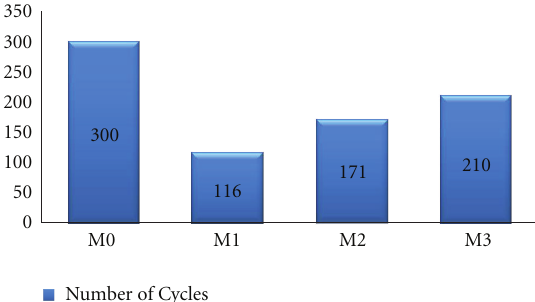
Figure 12: Number of freeze-thaw cycles survived ( N f ) by various